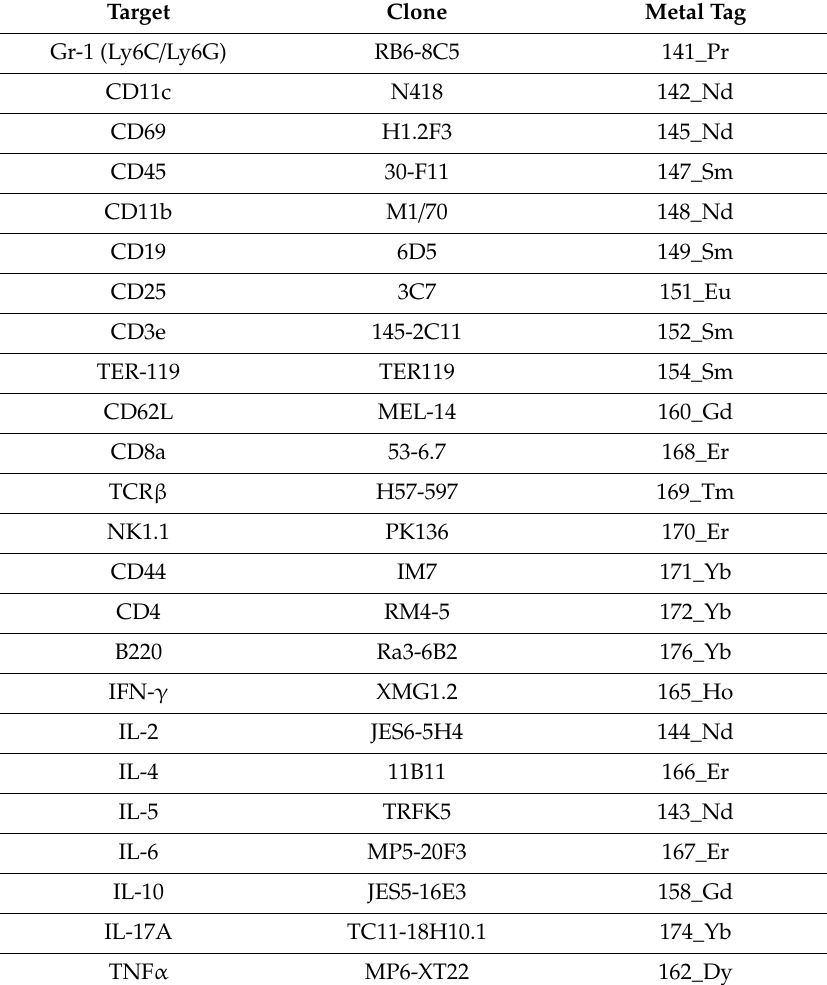
Table 1. The list of the antibodies used for mass